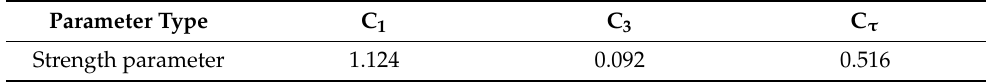
Table 9. Strength parameters of circle shear test.